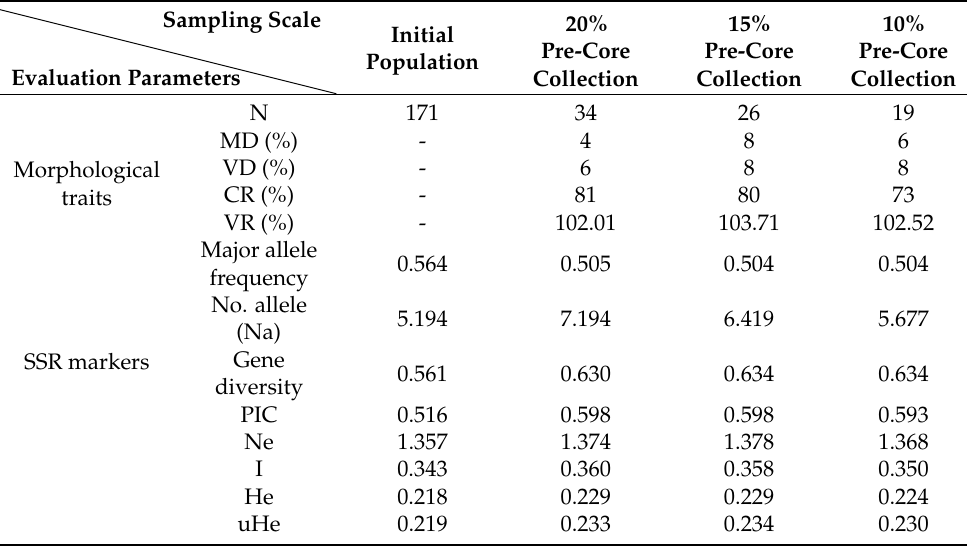
Table 2. Evaluation parameters of each primary core